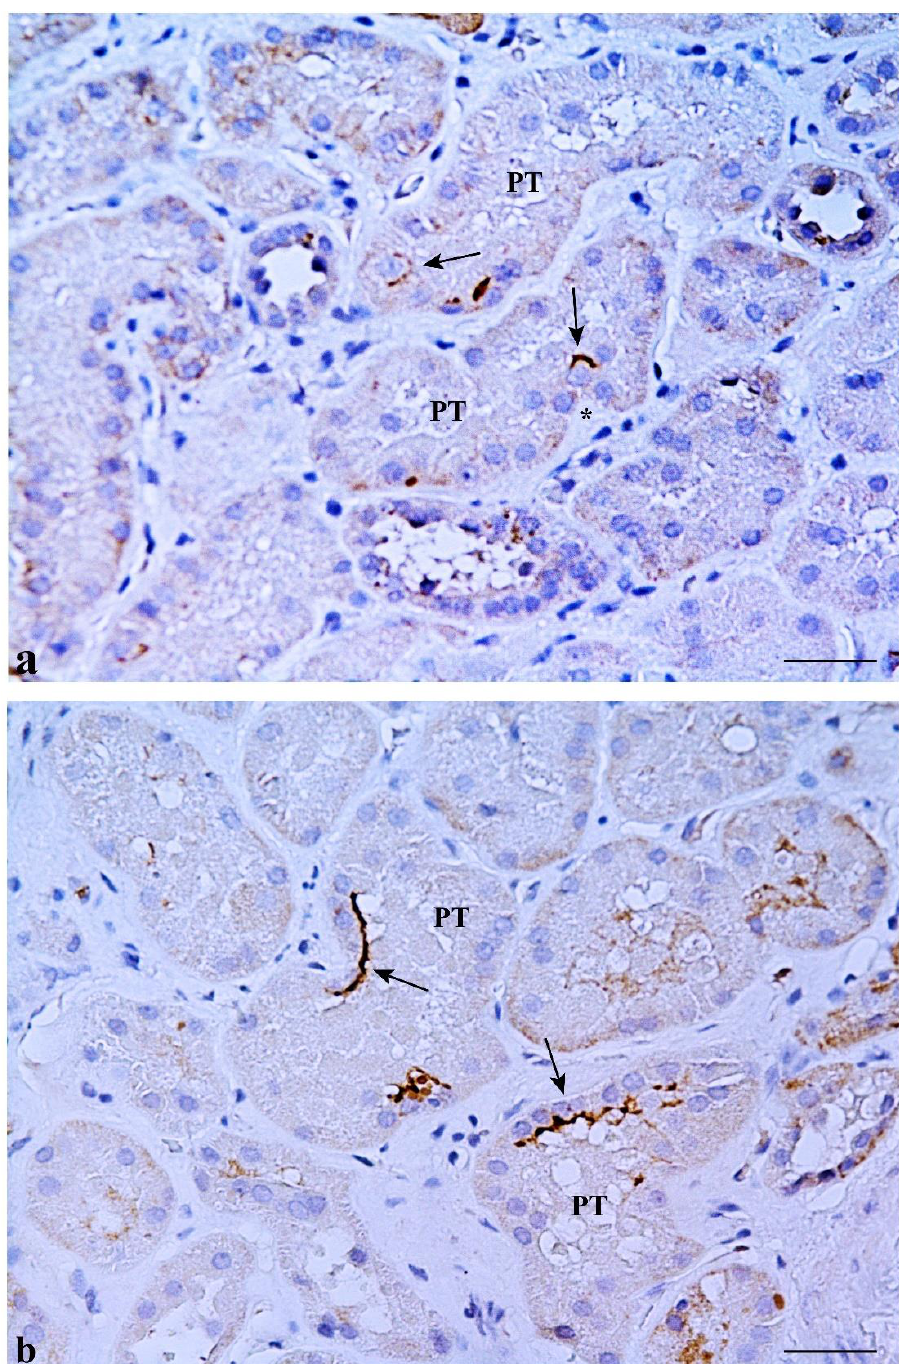
Figure 3. CD133 immunostaining in renal tissue. ( a ) Isolated cells expressing CD133 are present in two different proximal tubules (PT) (arrows). The apical staining appears in an arch shape. Note a CD133-positive cell showing an immune-stained arch in a tubular plicae (*). ( b ) CD133-positive cells are present in clusters in two PT (arrows). Scale bar: 100 µm.